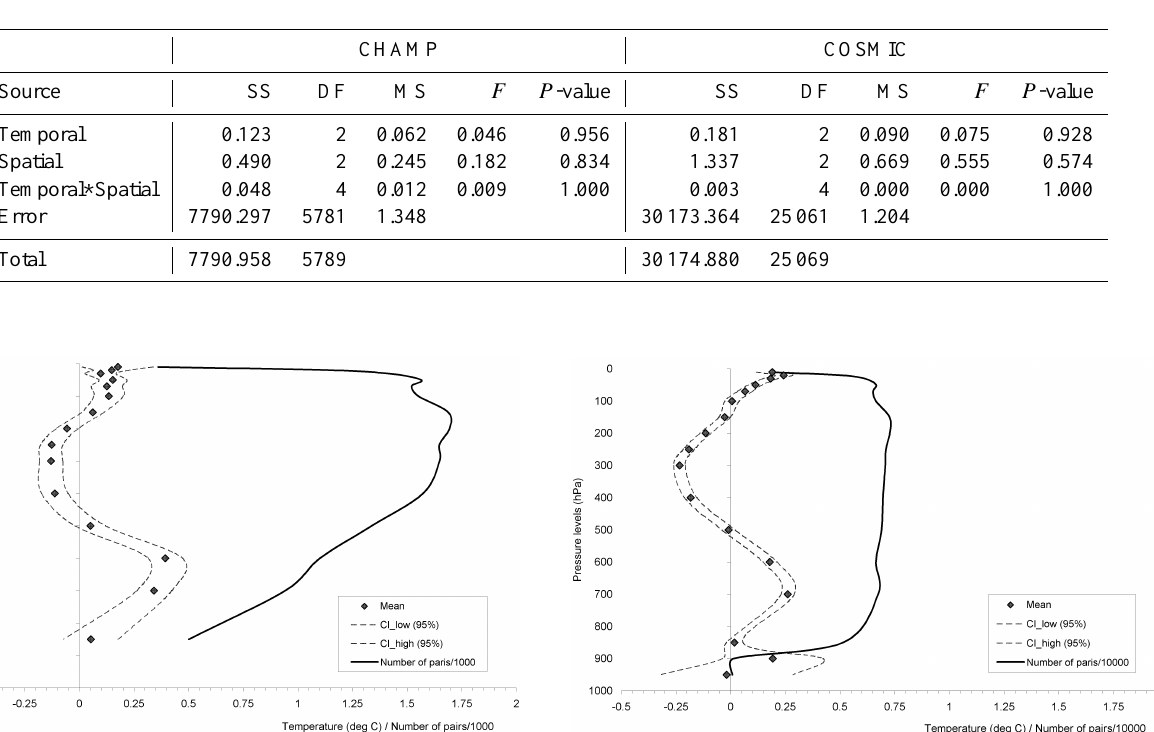
Table 2. Analysis of variance results (i.e. sum of squares (SS), degrees of freedom (DF), mean squares (MSS), F and P -value) for tempera- ture ( ◦ C) discrepancies between radiosonde and CHAMP data, and between radiosonde and COSMIC data.